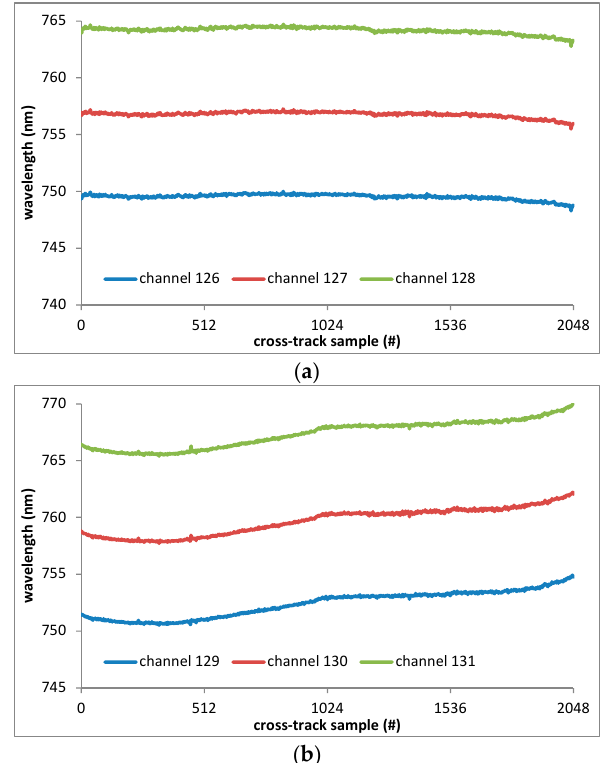
Figure 3. Cross-track central spectral wavelengths for channels centered near 760 nm for SPARK-01 ( a ) and -02 ( b ), respectively.